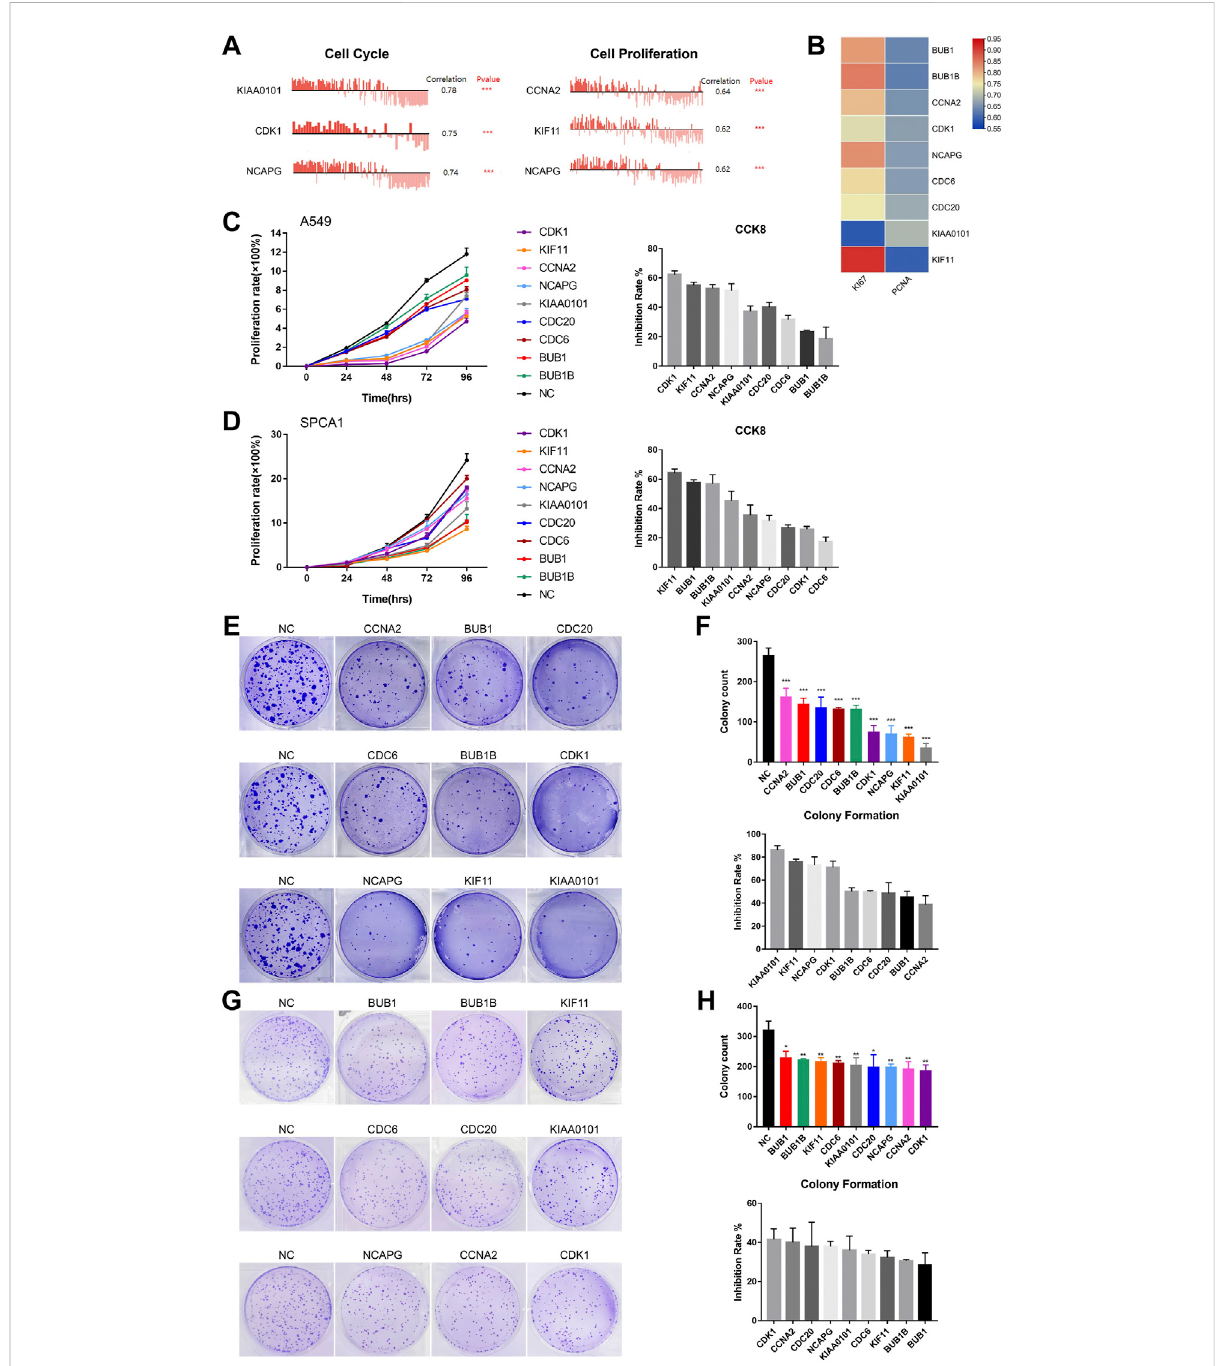
FIGURE 7 The biological functions ofhub genes inNSCLC. (A) The correlationbetweencell cycle, cell proliferation and hub geneexpressionatsingle cell level in NSCLC via CancerSEA database. (B) Correlation between Ki-67, PCNA and hub gene expression based on TCGA-LUAD analysis, n = 526. Statistical signi fi cance was tested using Pearson ’ s correlation coef fi cient. Correlation scores were analyzed by the Pearson correlation test. (C) Assessment of the proliferation of A549 cells transfected with siRNAs#1 targeting hub genes by CCK8 assay (Left). The inhibition rate of each siRNA#1oncellproliferation inCCK8assay(Right). (D) AssessmentoftheproliferationofSPCA1cellstransfectedwithsiRNAs#1targetinghubgenes by CCK8 assay (Left). The inhibition rate of each siRNA#1 on cell proliferation in CCK8 assay (Right). (E,F) Assessment of the colony formation ability of A549 cells transfected with siRNAs#1 targeting hub genes by colony formation assay. The inhibition rate of each siRNA#1 on colony formation. (G,H) Assessment of the colony formation ability of SPCA1 cells transfected with siRNAs#1 targeting hub genes by colony formation assay. The inhibition rate of each siRNA#1 on colony formation. * p < 0.05, ** p < 0.01, *** p < 0.001, **** p <